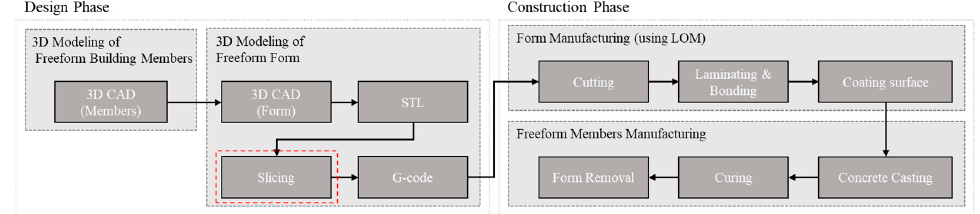
Figure 1. Overview of Fabrication Process for Freeform building .